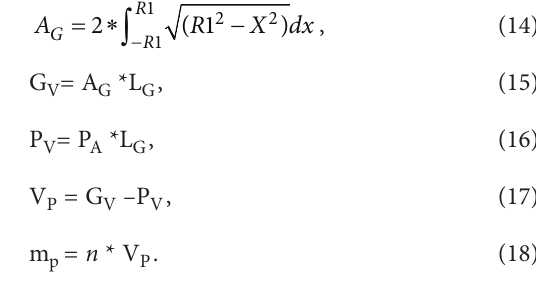
Fig. 6. Arcs in star and rose petal grain configurations (in the first replica)